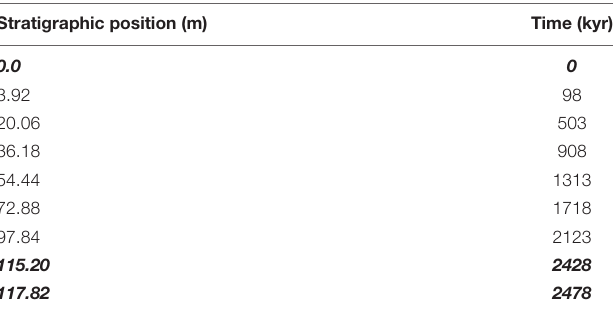
TABLE 2 | 405-kyr cycle and 100-kyr cycle picks (in bold and italic) based on MS minima in the MS stratigraphic series (see Figure 2B ) that were identified with elevated statistical significance by the MTM harmonic F-ratio test ( Figure 4A ) and bandpass filters ( Figure 2D ). Stratigraphic position (m)